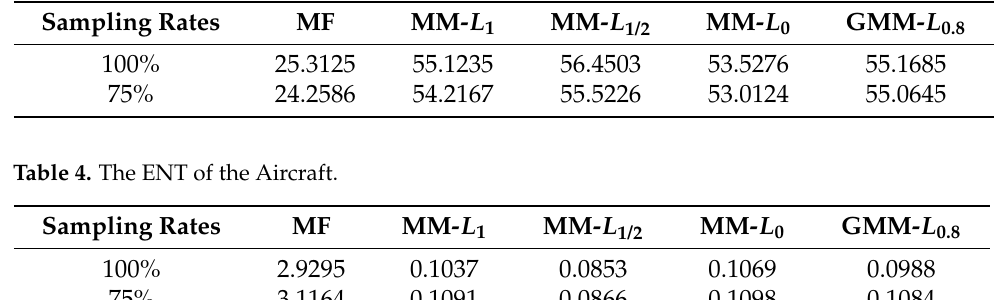
Figure 5. The imaging results of the aircraft corresponding to the 75% sampling rate. ( a ) The MF result. ( b ) The MM- L 1 result. ( c ) The MM- L 1/2 result. ( d ) The MM- L 0 result. ( e ) The GMM- L 0.8 result. Table 3. The TBR of the Aircraft.